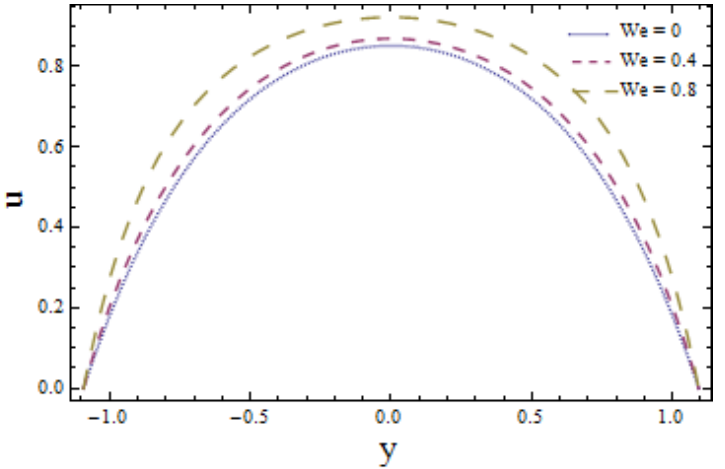
Figure 5. Velocity u versus y with We when (cid:101) = 0.1, x = 0.2, t = 0.01, E 1 = 0.4, E 2 = 0.2, E 3 = 0.3, m = 0.04, n = 0.4 and m 1 =